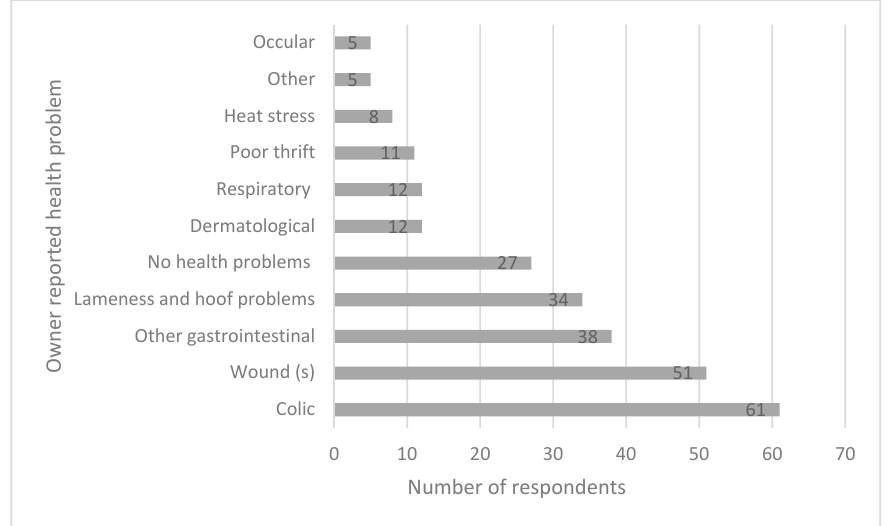
Figure 3. Owner-reported health problems in donkeys over two years prior to questioning. Note that some participants gave more than one response.